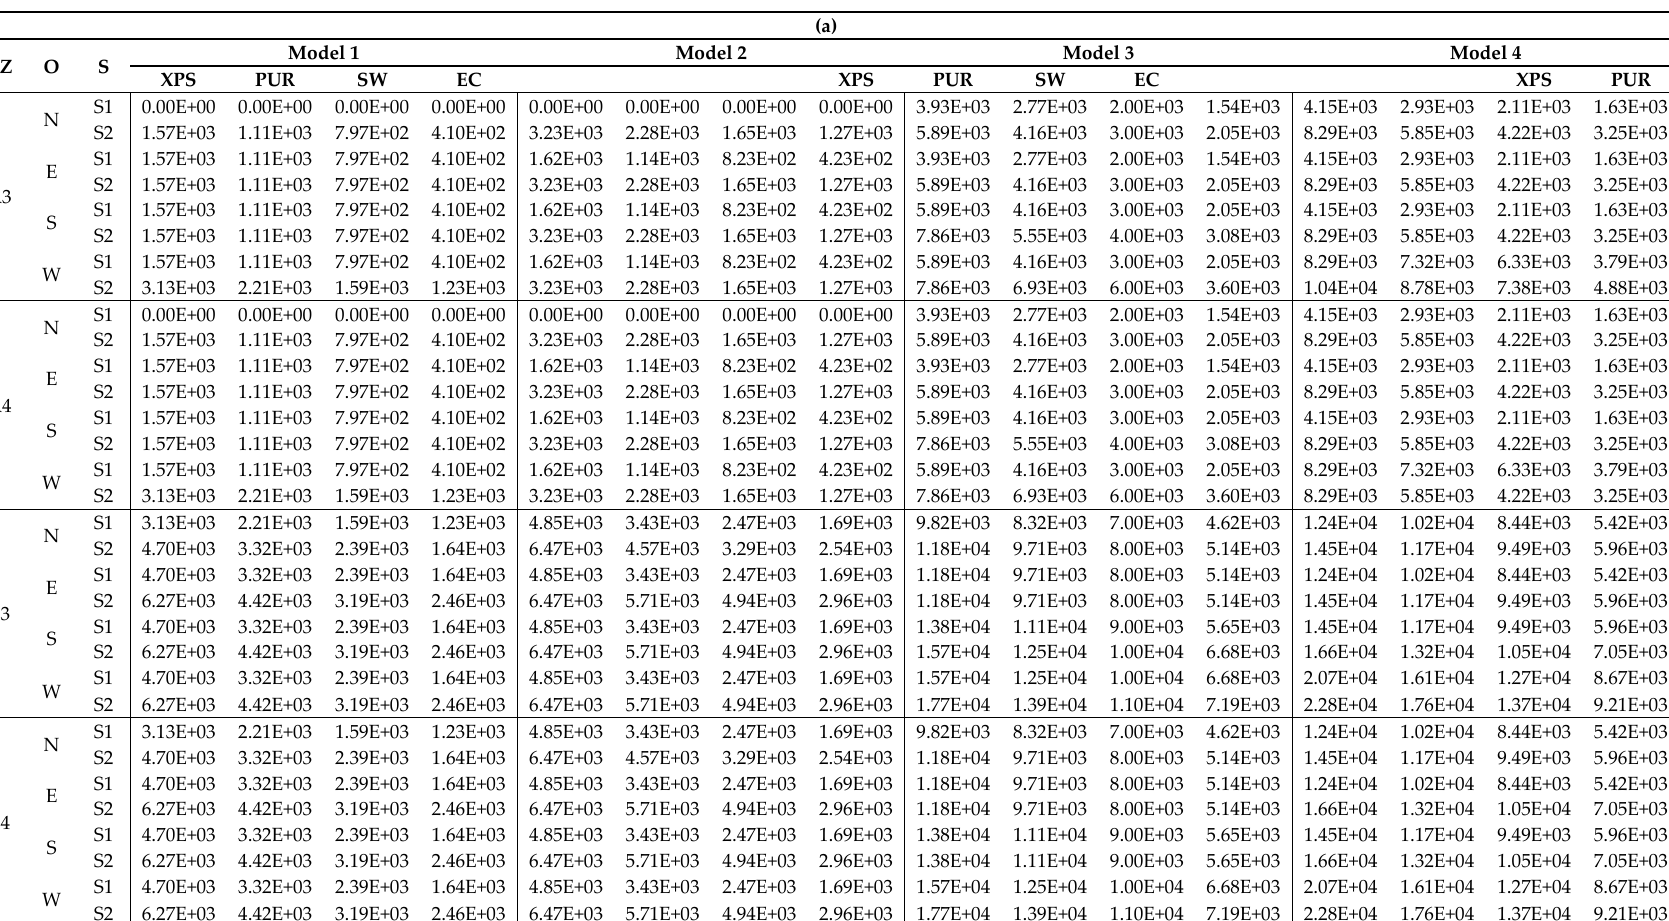
Table A5. Emissions of CO 2 according to climate zone (CZ), orientation (O), constructive solution (S), building model and insulation material model (in Kg CO 2 ), for H2.